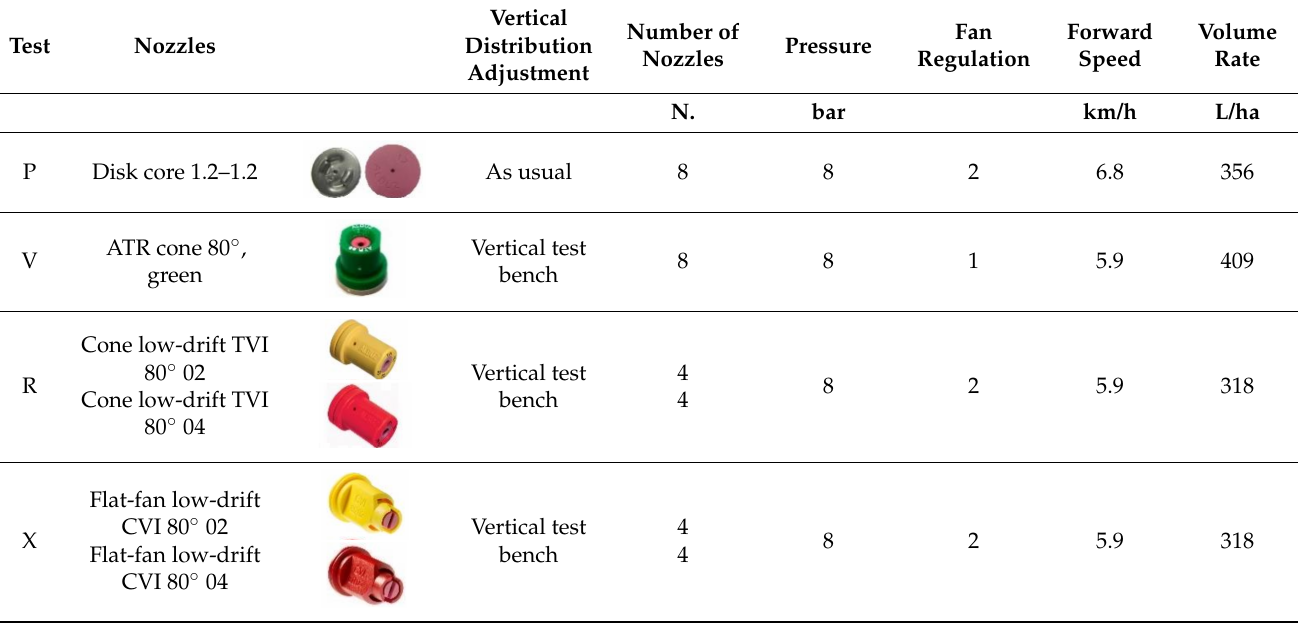
Table 1. Main characteristics of the sprayer configurations under